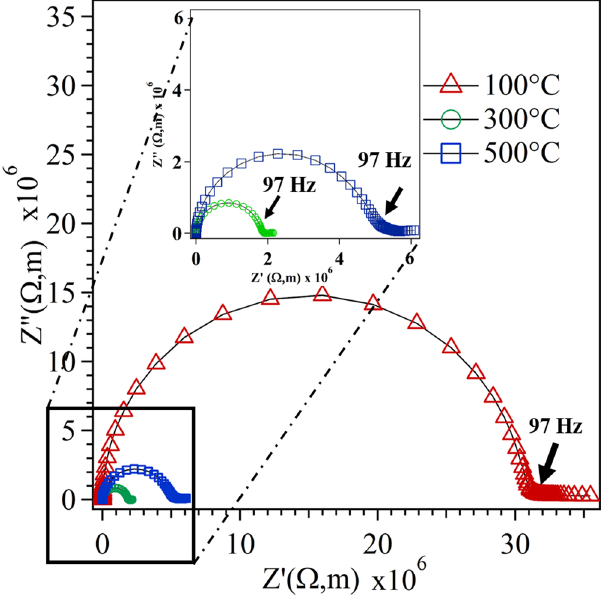
Figure 12. Complex impedance plot of all thin films measured at 600 °C in air